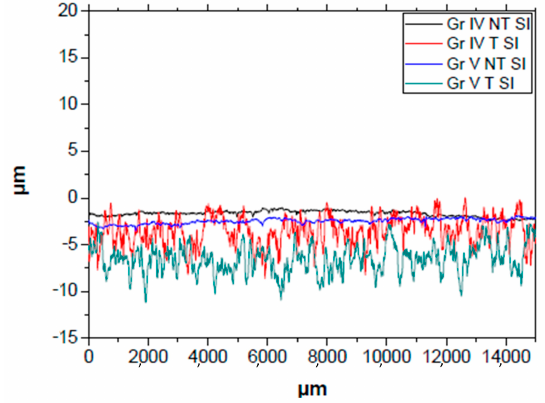
Figure 9. Roughness profile of the treated with TiO 2 samples. (GR IV: Titanium grade IV; GR V: Titanium grade V; T: SLA treated; NT: SLA non-treated; SI: Treated with TiO 2 film).